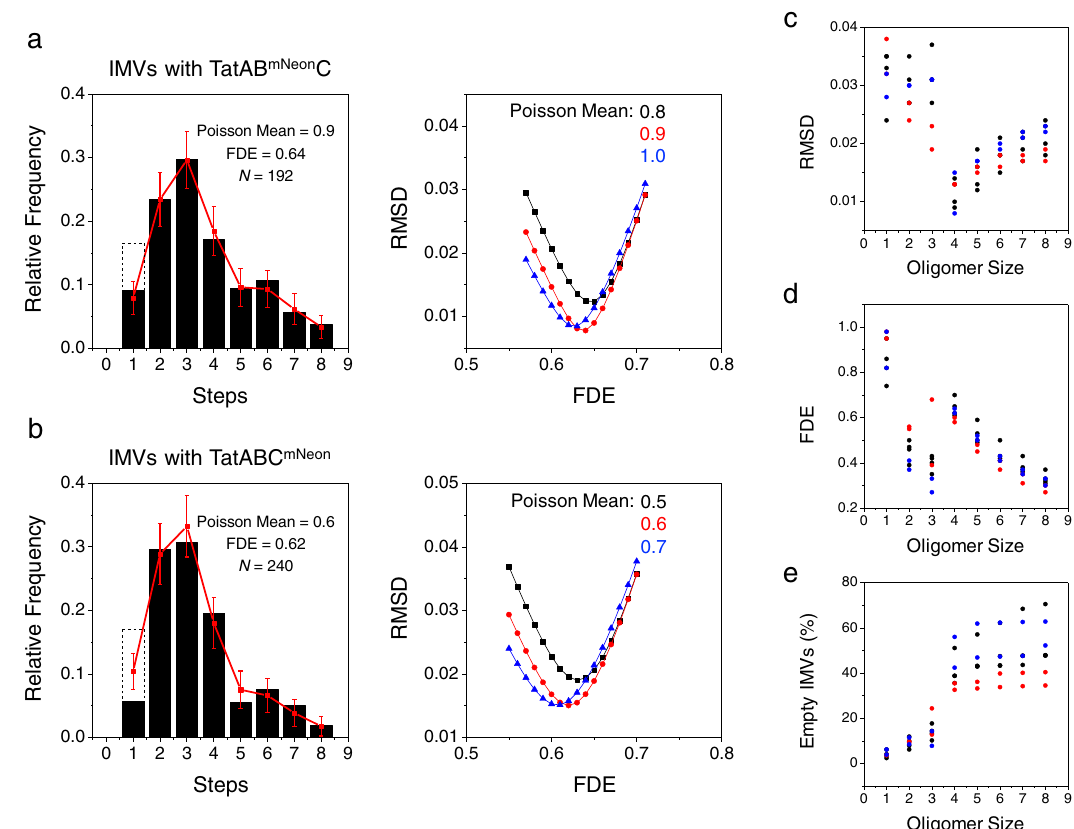
Fig. 8 The tetrameric Tat receptor complex. a , b Best fi ts to photobleaching data for IMVs containing TatAB mNeon C or TatABC mNeon . These are the same data as shown in Fig. 6a, b. By varying the assumed oligomerization state (monomers to octamers), the Poisson mean (which describes the expected distribution pattern for the number of Tat complexes in the IMVs), and the FDE, the best fi ts to the experimental photobleaching data for IMVs containing TatAB mNeon C ( a ) or TatABC mNeon ( b ) indicate that the Tat receptor complex includes four copies each of TatB and TatC. Sample fi ts for other oligomerization states are shown in Supplementary Fig. 10; parameters for the different oligomeric fi ts are reported in Supplementary Table 1 (data in blue). The single-step data in the histograms are corrected (solid black, see Fig. 6); uncorrected values are also indicated (dashed black boxes). Only step bins 2 – 8 were included in the RMSD for the best fi ts shown (red); inclusion of the corrected single step bin for both data sets leads to identical conclusions (see Supplementary Table 1). Error bars are standard deviations (SDs) obtained from 5000 simulated distributions of N values each, where N is the number of experimental measurements from a single IMV preparation, as indicated. c – e Summary of fi t parameters and predicted empty IMVs. The RMSDs ( c ), FDEs ( d ), and predicted percentage of empty IMVs ( e ) assuming various oligomerization states for three preparations each of IMVs containing TatAB mNeon C or TatABC mNeon show a transition between the trimer and tetramer models. The best fi t (lowest residuals between the fi t and the data using RMSD) was obtained assuming a tetramer [as shown in a , b ]. Raw data are summarized in Supplementary Table 1 (with identical color coding), which describes the different IMV preparations and how the data were